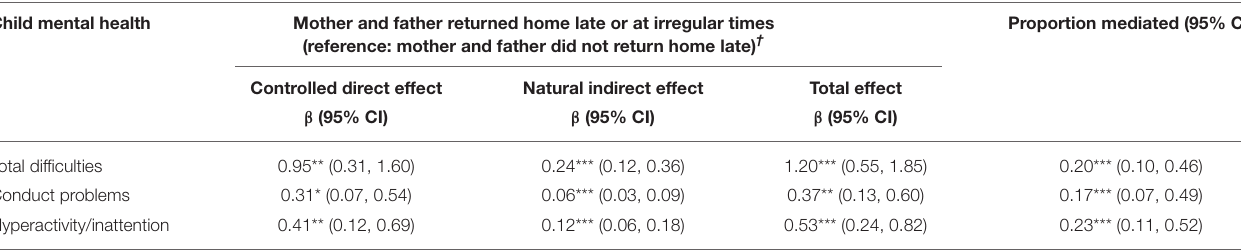
TABLE 4 | Mediation by parent-child interaction of the relationship between mother and father who returned home late or at irregular times vs. mother and father who did not return home late and child total difficulties, conduct problems, or hyperactivity/inattention score. Child mental